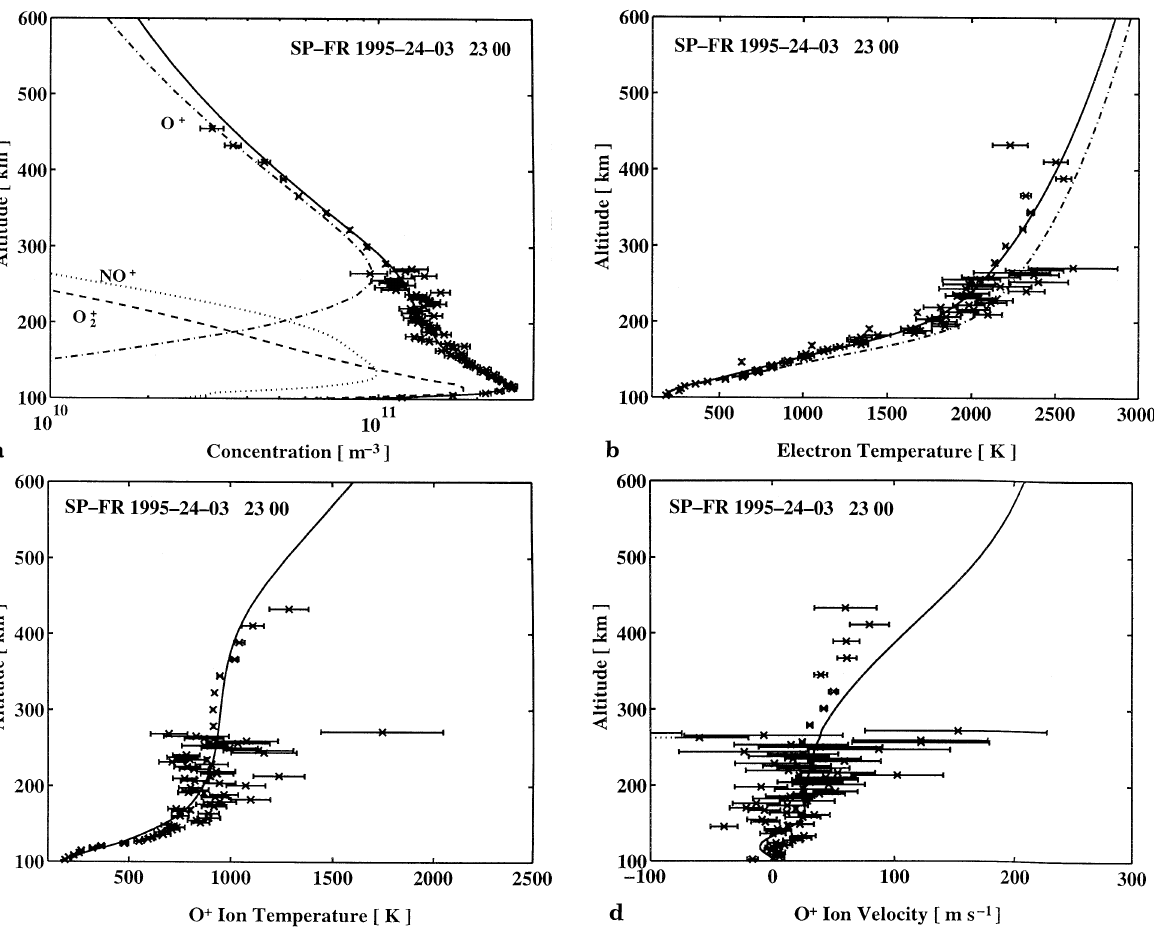
indication on the composition; b electron temperature ( dot - dashed line corresponds to standard vibration excitation of N (cid:50) and the full line to a double vibration excitation of N (cid:50) ); c O (cid:96) -ion temperature; d O (cid:96) -ion